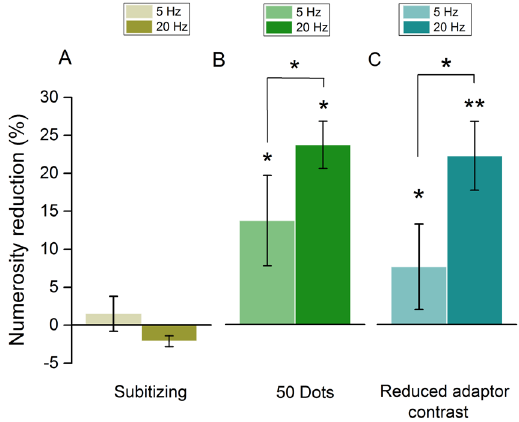
Figure 5. Adaptation to different numerosity regimes and to low contrast adapters. Panels A,B: Perceived numerosity reduction induced by motion adaptation in the subitizing range (reference numerosity = 3 dots; panel A) or the estimation range (numerosity 3 times higher than in Exp 1; panel B). Motion adaptation did not affect perceived numerosity in the subitizing range. On the contrary, perceived numerosity in the estimation range was found to be robust regardless reference numerosity being 15 (as in Exp 1) or 50 dots. (C) Motion adaptation-induced numerosity reduction effects after adaptation to translational motion, in the condition where the adaptor contrast was reduced to 50%. Error bars represent S.E.M. * p < 0.05, ** p <